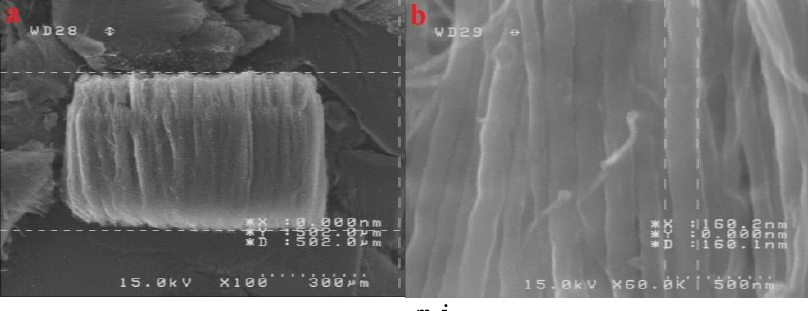
mi Figure 7. SEM image shows align microstructure of samples and (a) length and (b) formation of VA-CNTs (Mirbagheri et al.,